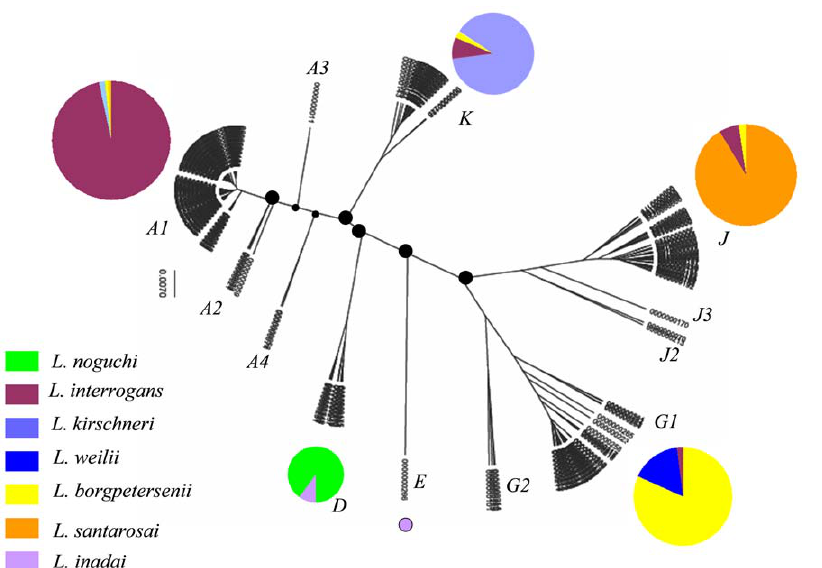
Figure 3. Genetic clustering and Bayesian inferred phylogeny of Leptospira isolates and strains based on MLST analysis. (See supplementary information, tables S1 and S2 for detailed information on all the isolates/strains analyzed.) Clades or embranchment corresponding to different species types have been marked in different colors. Major clades and minor clades have been identified by code names (A to K) which overlap with the designation of similar clades identified by FAFLP technique. Identities of individual isolates need not be comprehensible in the tree itself, but they can be read clearly in the supplementary Table S2. The analysis was performed using BEAST version 1.5.2, the tree was annotated using TreeAnnotator v1.5.2 and was visualized through FigTree v1.2.2.